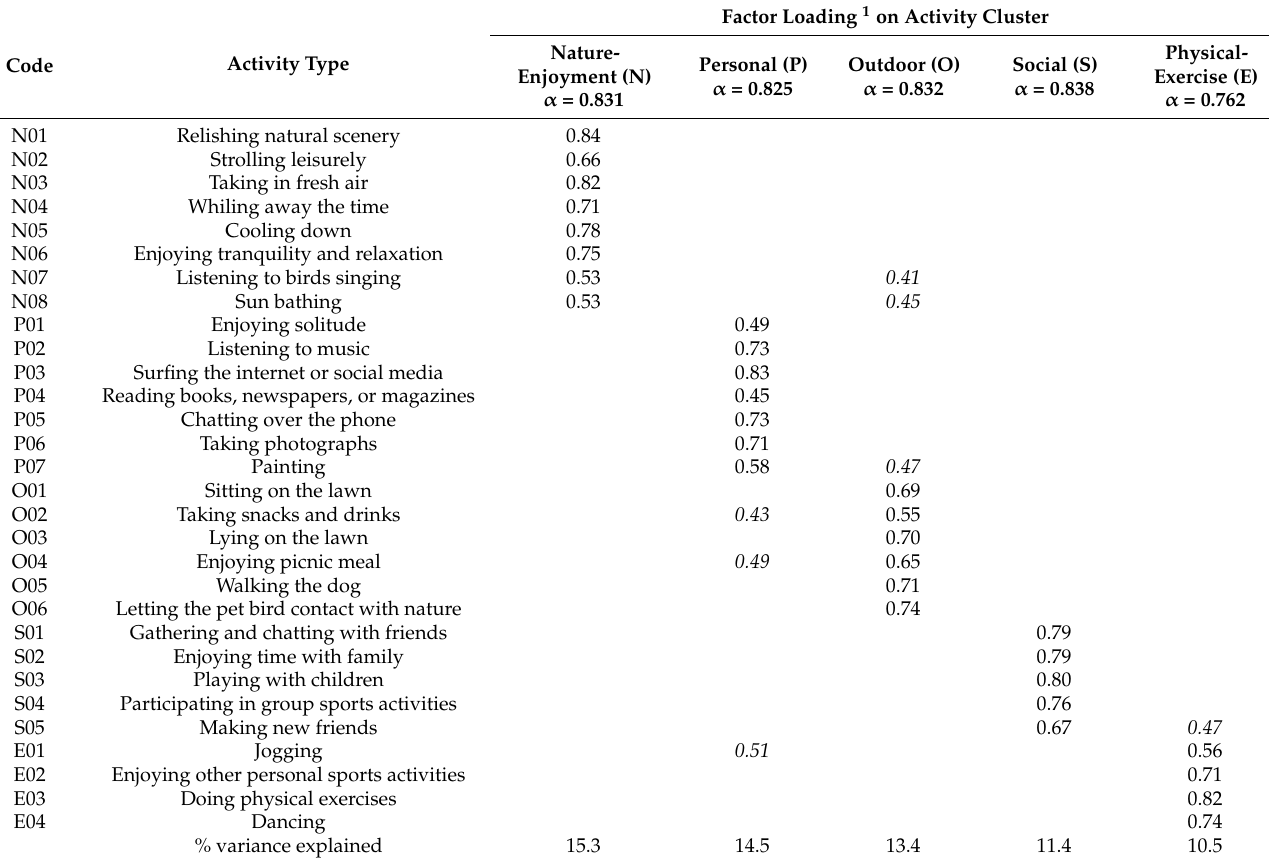
Table 3. The 30 visitor activity types are classified into five activity clusters based on their PCA factor loadings in relation to activity engagement level. Cronbach’s alpha ( α ) is >0.7 for all